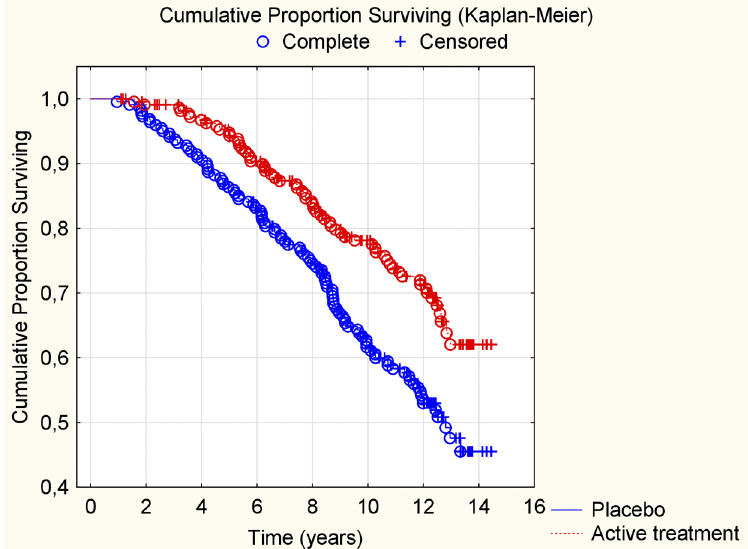
Fig 2. Kaplan-Meier graph illustrating cardiovascular mortality during a follow-up period of 12 years of those supplemented with selenium and coenzyme Q10 versus placebo for four years on top of regular pharmaceutical